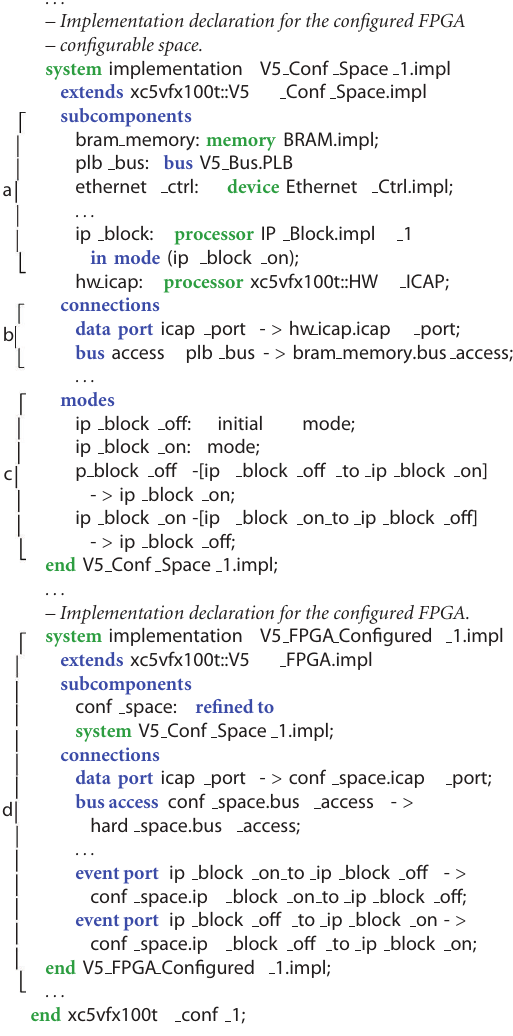
Figure 7: An AADL package defining the dynamically configurable zone of the Virtex 5